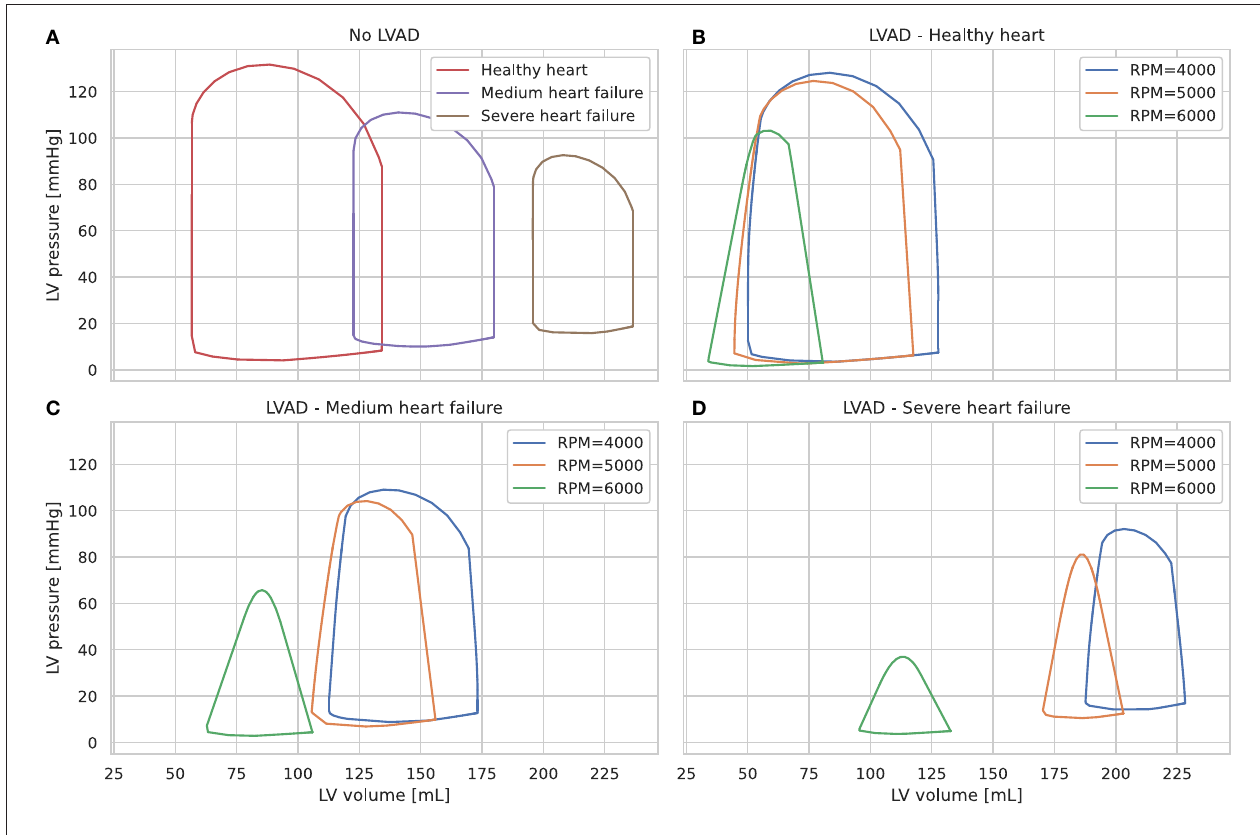
FIGURE 2 | Left ventricle pressure-volume diagrams for different stages of heart failure, without LVAD (A) and with LVAD for different pump speeds (B–D) .